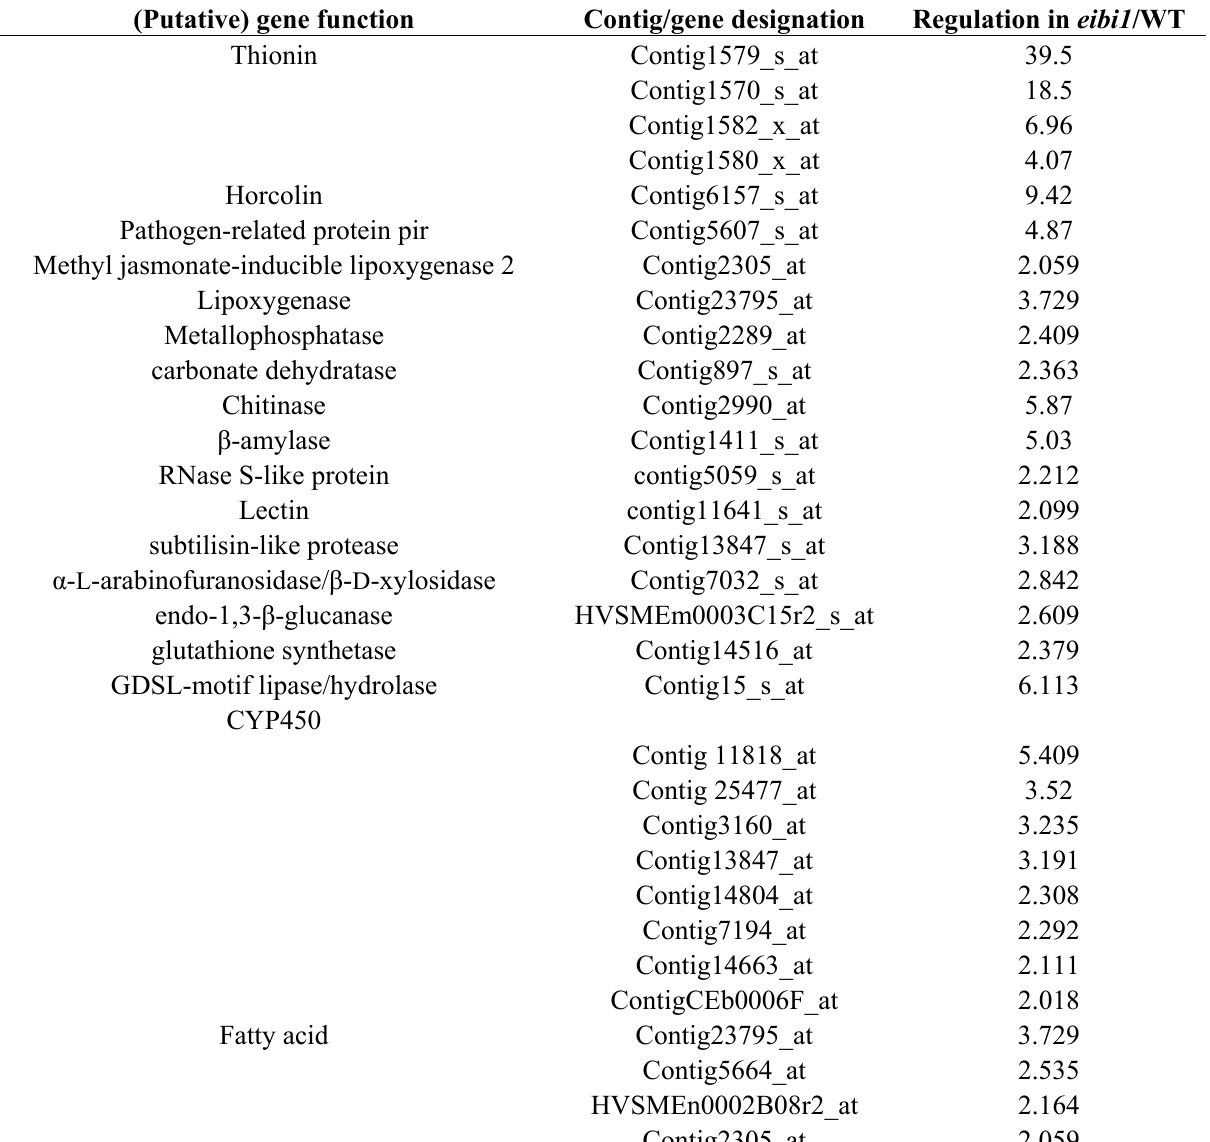
Table 1. The up-regulated stress related marker/gene in eibi1